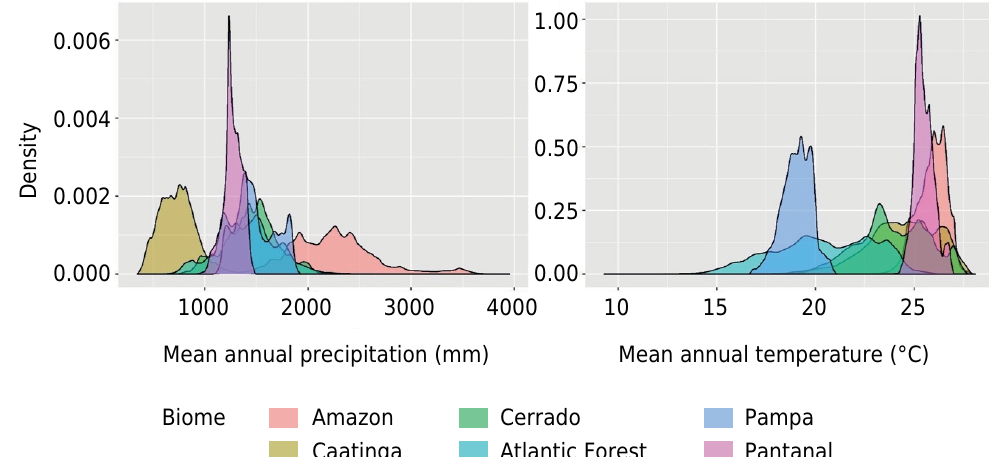
Figure 1. Distribution of frequency for mean annual precipitation (MAP) and mean annual temperature (MAT) across the six major Brazilian biomes, namely Amazon, Caatinga, Cerrado, Atlantic Forest, Pampa and